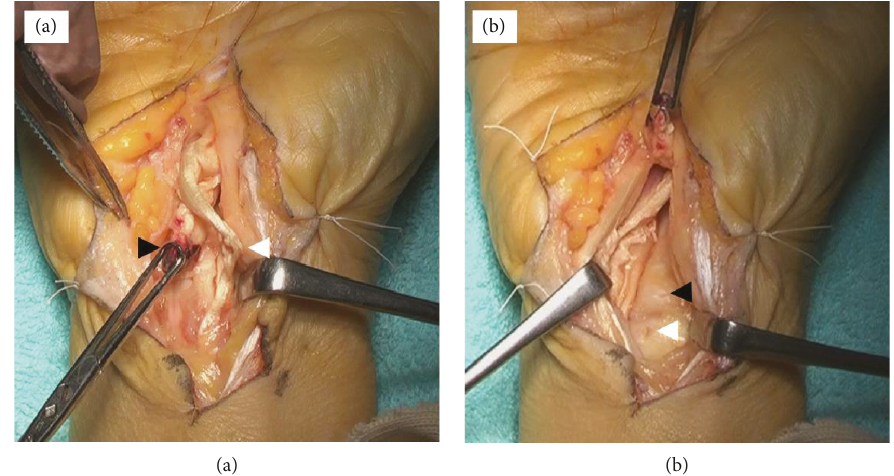
Figure 2: Intraoperative fi ndings. (a) Rupture of the fl exor digitorum profundus of the index fi nger (black arrowhead). Degeneration of the fl exor digitorum super fi cialis of the index fi nger (white arrowhead). (b) A pinhole-sized perforation of the distal radioulnar joint capsule (white arrowhead). The bony spur covered with a joint capsule (black